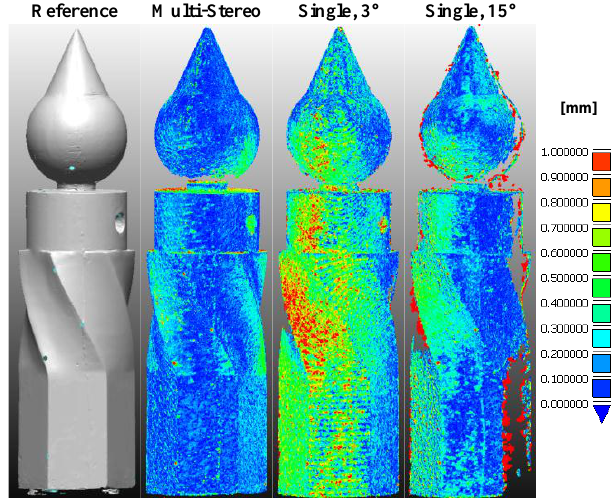
Figure 12: Difference of point cloud to reference surface, visualized using the software CloudCompare. Reference surface from structured light, result from multi-stereo, result from single stereo model at 3° mean intersection angle, result from single model at 15°.